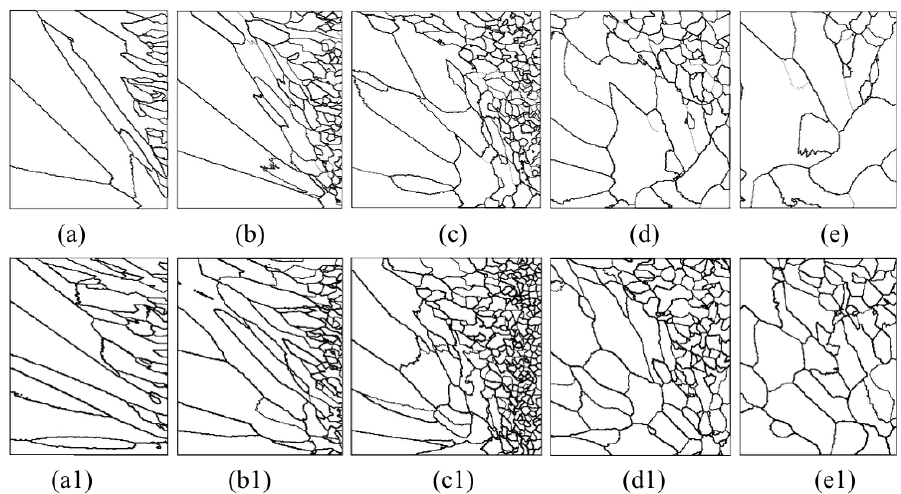
Figure 14. Microstructure morphology predicted of different axial sections with the cooling temper- ature of 25 °C ( a – e : without nickel coating; a1 – e1 : with nickel coating).